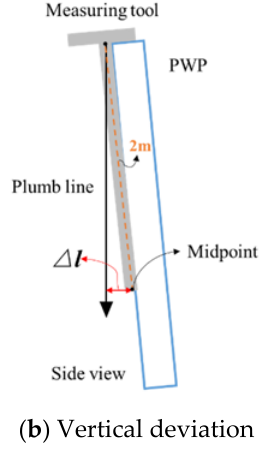
Figure 2. Conventional calculation method.